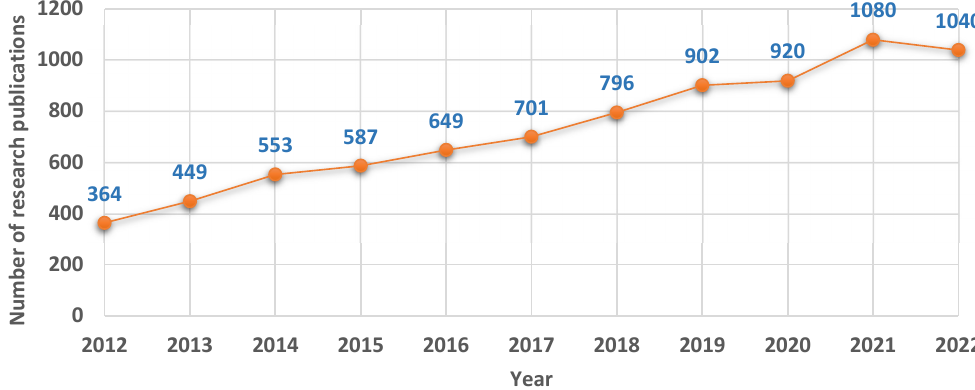
Figure 1. Number of research publications on human action recognition over the last ten